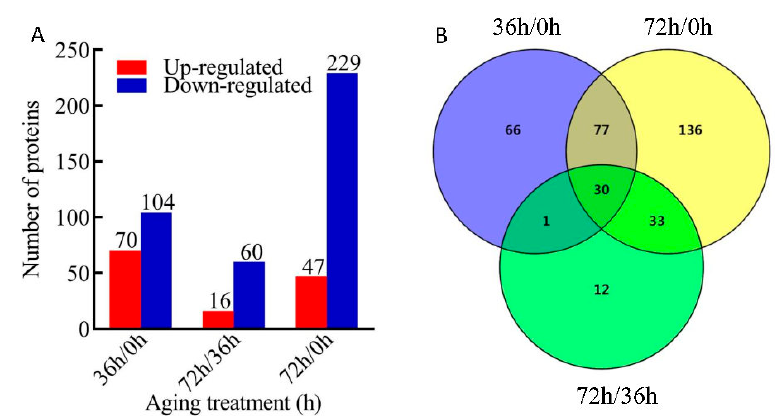
Figure 2. The profile of the differentially expressed proteins (DEPs). ( A ) Number of DEPs identified in different comparison groups with different artificial aging treatments (AAT); ( B ) Venn diagram illustrating the number of identified proteins in the 3 different comparison groups (36 h/0 h, 72 h/0 h and 72 h/36 h). The fold-change cutoff was set when proteins with quantitative ratios over 1.3-fold change was considered up-regulation while quantitative ratio less than 1/1.3-fold change was considered as down-regulation. There are three biological repeats for each treatment.